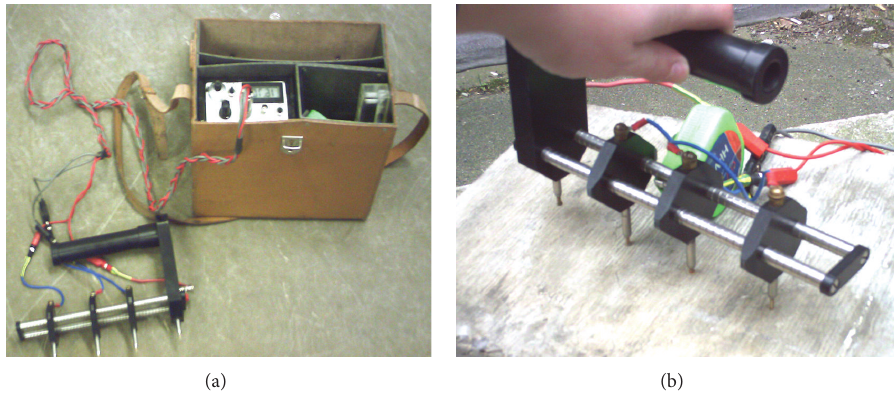
Figure 5: Concrete resistivity measurement: (a) test setup and (b)